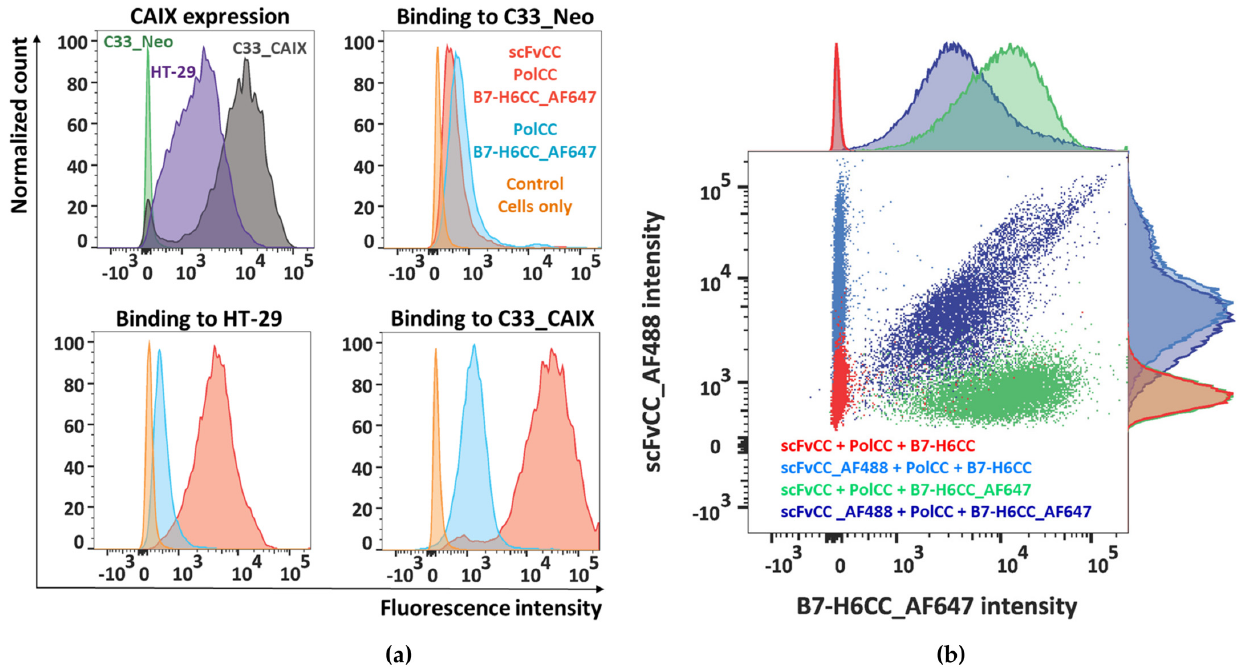
Figure 5. Binding of the polymer–protein complexes to the surface of cell lines with different levels of CAIX expression. ( a ) Cells were first characterized for the CAIX expression levels by M75 mAb (first histogram), then HT-29, C33_Neo, and C33_CAIX cells were stained with polymer–protein complexes (scFvCC + PolCC + B7-H6CC, in red), or with control complexes lacking the targeting scFvCC (PolCC + B7-H6CC, in blue), or were analyzed unstained (in orange). ( b ) HT-29 cells were stained with polymer–protein complexes always containing both scFvCC and B7-H6CC proteins; additionally, proteins were combined with their fluorescently labeled variants (AlexaFluor488 labeled scFvCC, AlexaFluor647 labeled B7-H6CC) to show the double color labeling and thus binding of complete particles to the cell